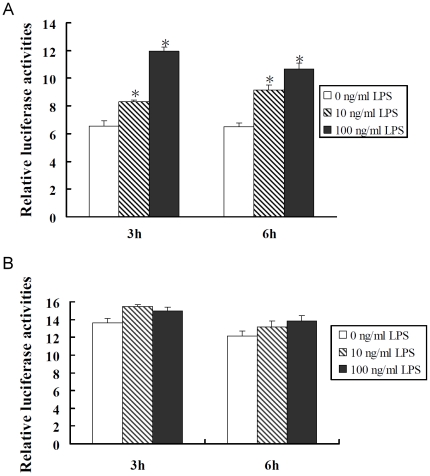
Effect of LPS on CD14 promoter activity.(A) C9 rat hepatocytes and (B) HSC-T6 cells were transfected with plasmid of pCD14p-376. After transfection for 24 h, cells were treated with LPS (10 and 100 ng/mL) for 3 and 6 h. Cells were harvested and luciferase activity was measured. Data are expressed as mean±SE of the luciferase activities relative to the pGL3 expression in the respective control groups. * indicates P<0.05 versus time-matched values for the control cells (without LPS treatment).